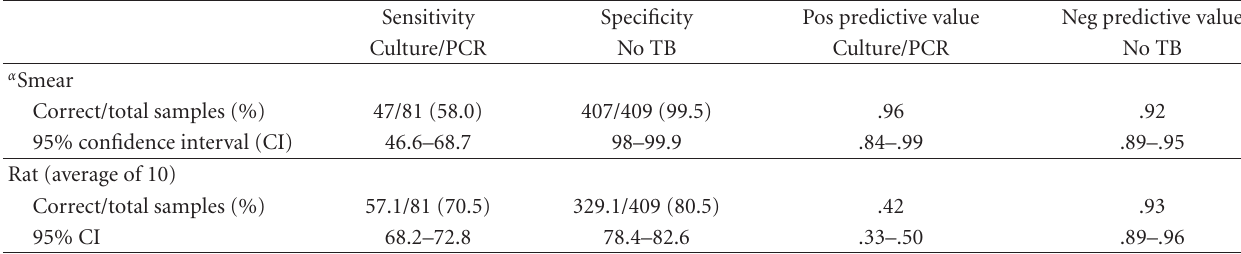
Table 4: Patient-wise smear microscopy and average rat reference